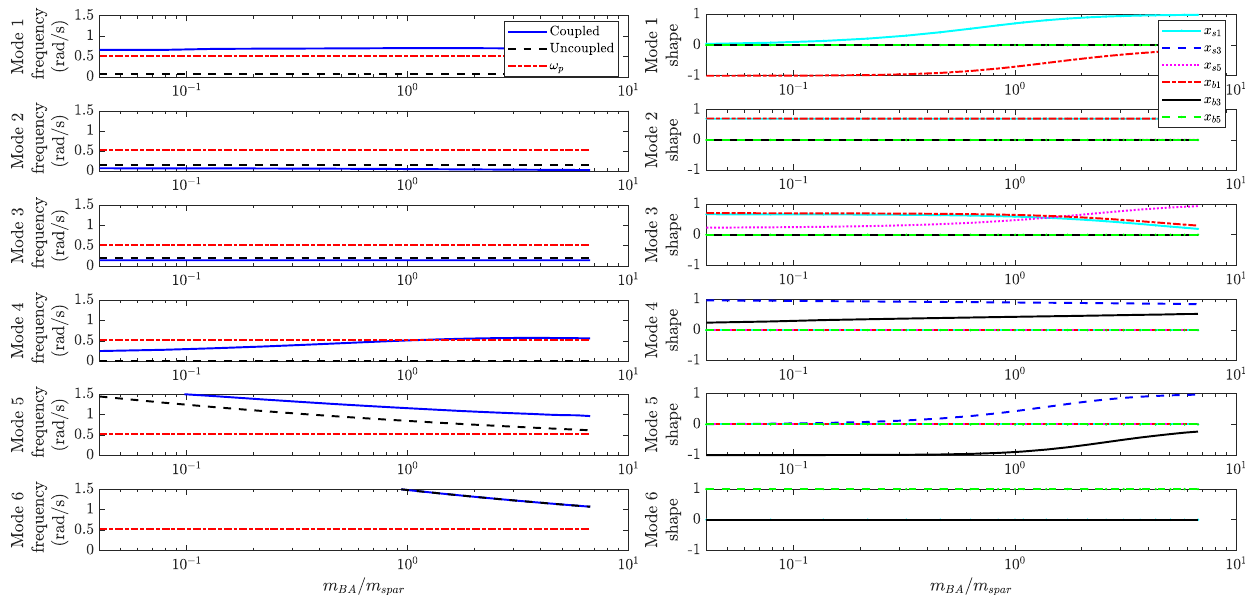
Figure 11. Modal frequency ( left ) and modal shape ( right ) as a function of m BA / m spar for D BA / R BA = 1.00, ∆ x = 50m, and L k = L b =